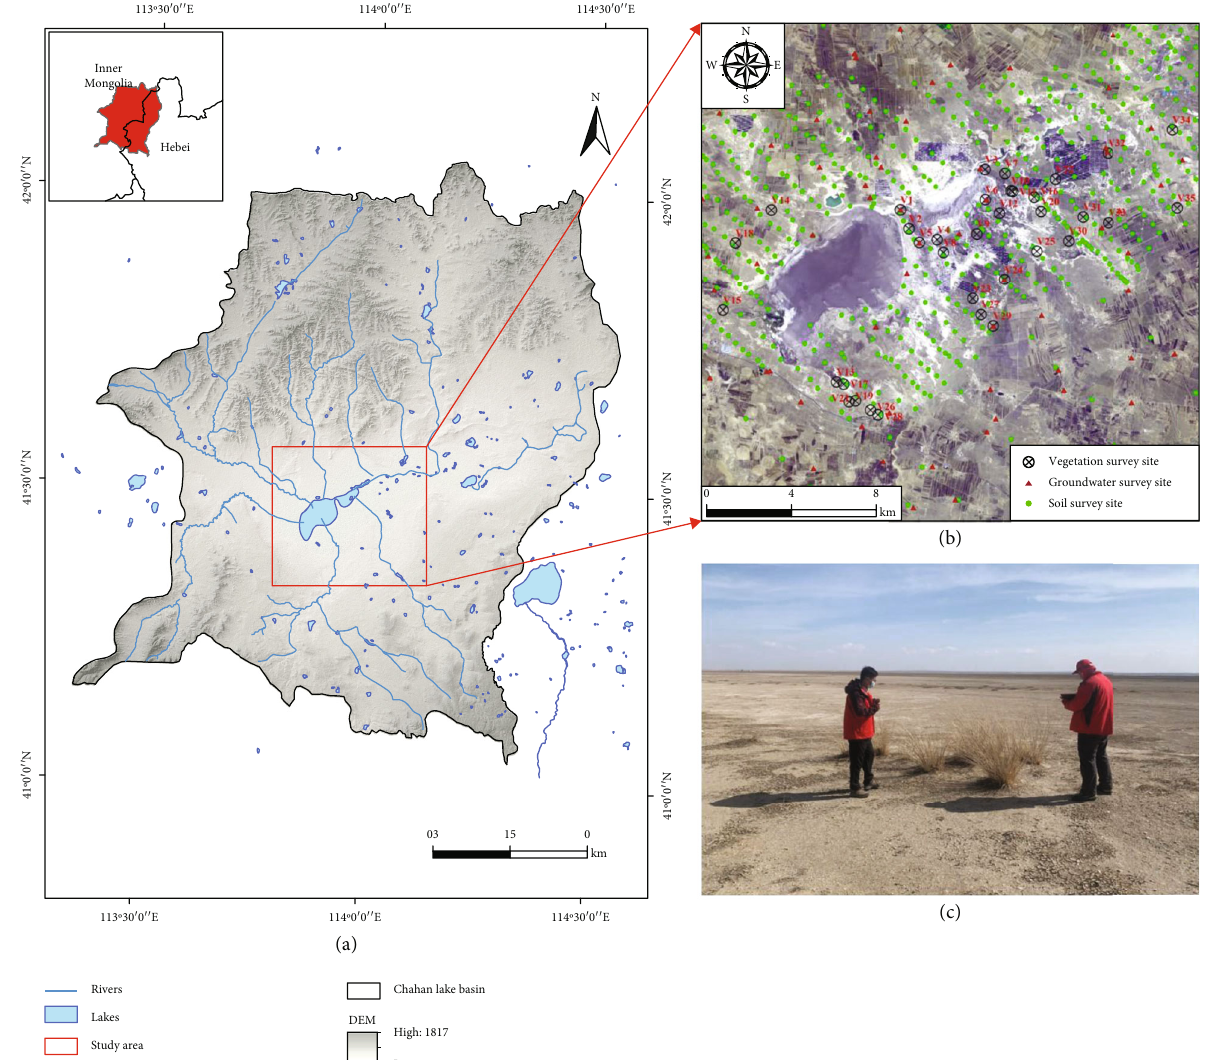
Figure 1: Geographic location and sampling point location map of the study area: (a) geographical location of the study area; (b) high- de fi nition remote sensing images and sampling points in April 2021; (c) fi eld survey in April